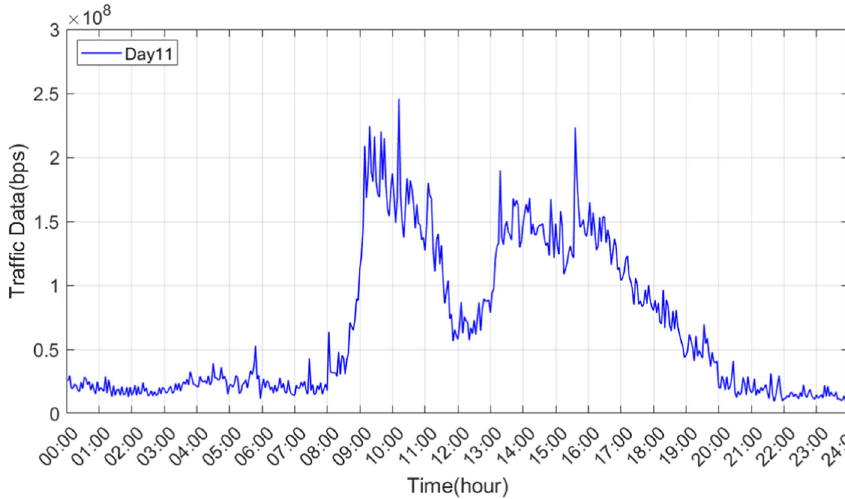
Fig. 5 Workdays data characteristics